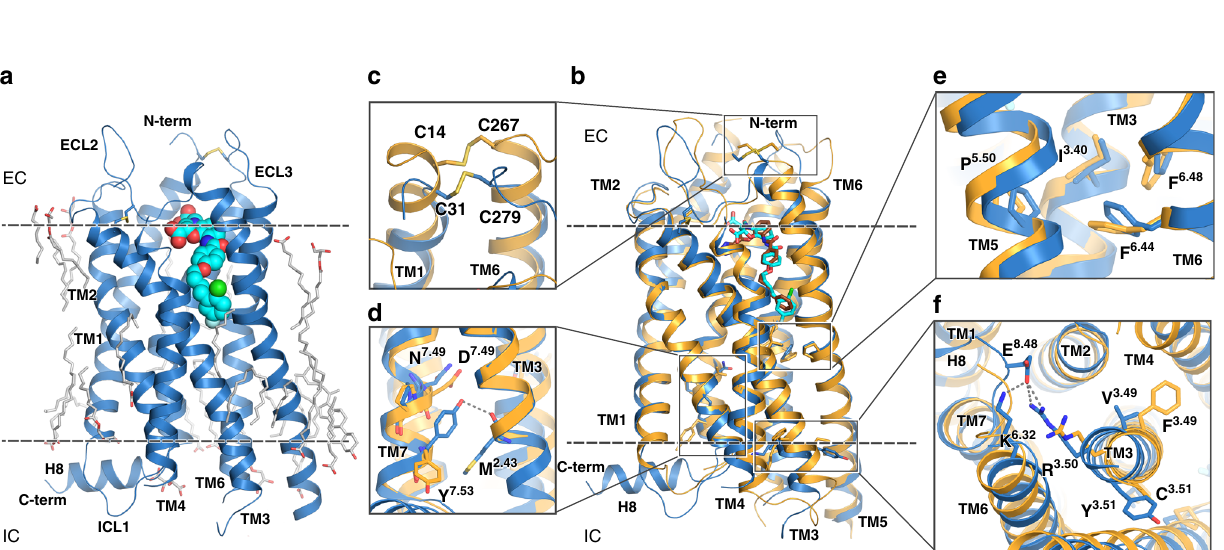
Fig. 1 Structure of CysLT 2 R. a Overall structure of CysLT 2 R-11a (C222 1 space group). b Structural superposition of CysLT 2 R-11a (blue; C222 1 space group) with CysLT 1 R-pranlukast (yellow). c Comparison of disul fi de bridges between CysLT 1 R (yellow) and CysLT 2 R (blue). Comparison of functional motifs: NPxxY ( d ) P-I-F ( e ), and DRY ( f ). Membrane boundaries are shown as dashed lines in a and b